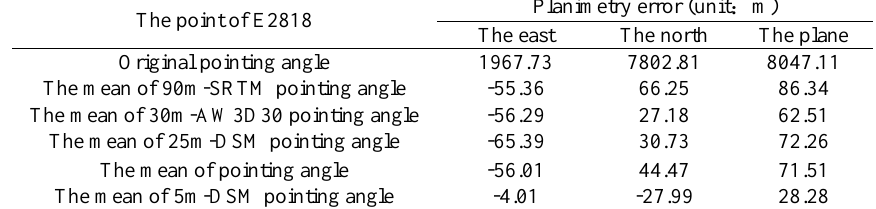
Table 6. The position error of the ground detector using the pointing angle derived from DSM with different grid